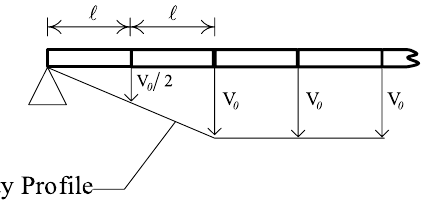
Figure 8. Example of approximate initial velocity profile when the simply supported beam is discretized into uniform mass elements.